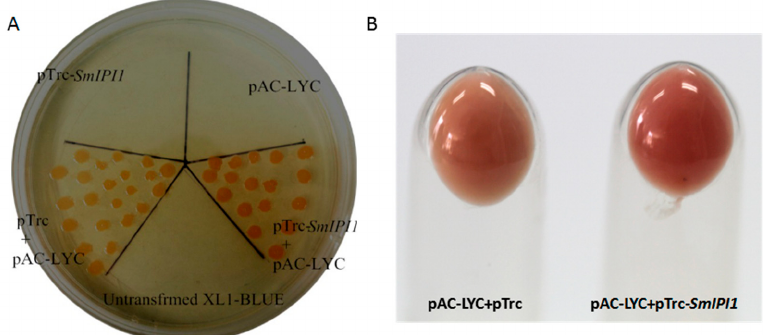
Figure 5. Color complementation and enhanced lycopene accumulation due to expression of SmIPI1 in engineered E. coli for lycopene biosynthesis. ( A ) The plate was divided into five sections, which were respectively inoculated with bacteria containing the corresponding plasmids as indicated on the plate; ( B ) The carroty bacterial clones including pTrc- SmIPI1 and pAC-LYC were darker because of lycopene accumulation.